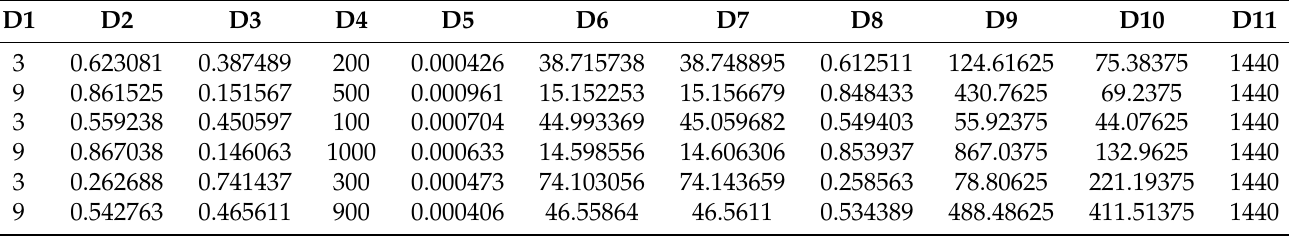
Table 2. Partial dataset (Part I).